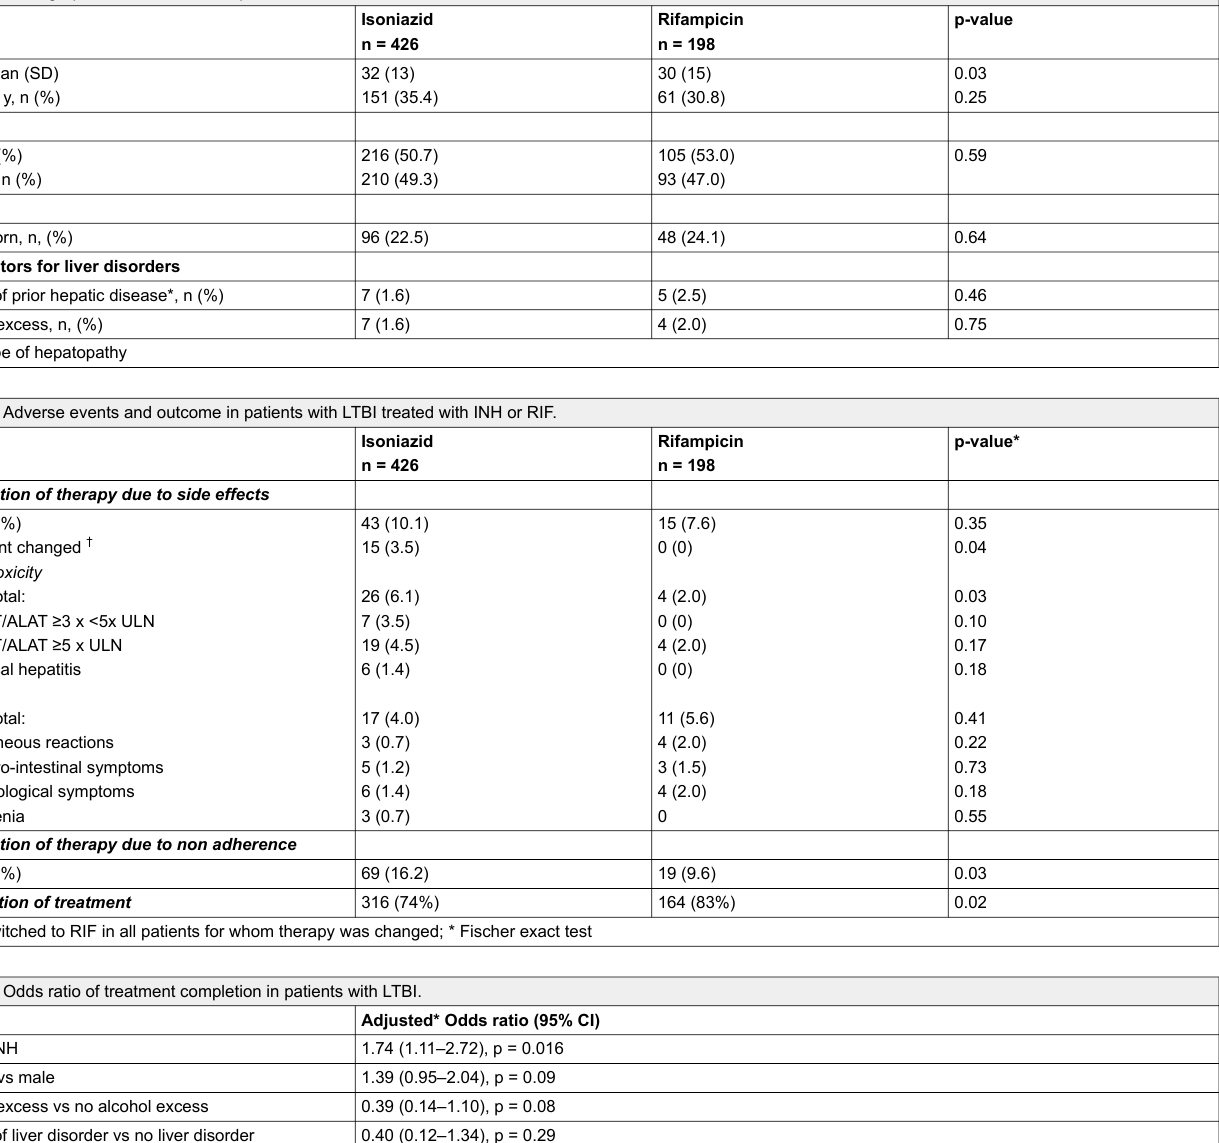
Table 1: Demographic characteristics of patients with LTBI included at baseline.